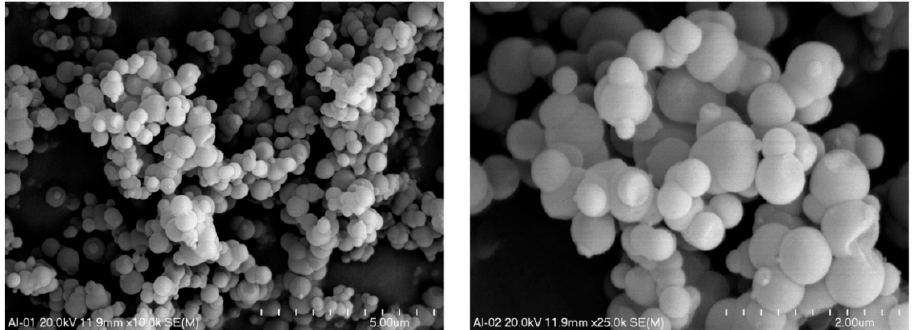
Figure 4. SEM images of spherical silica-alumina MCM-41 at various magnifications.